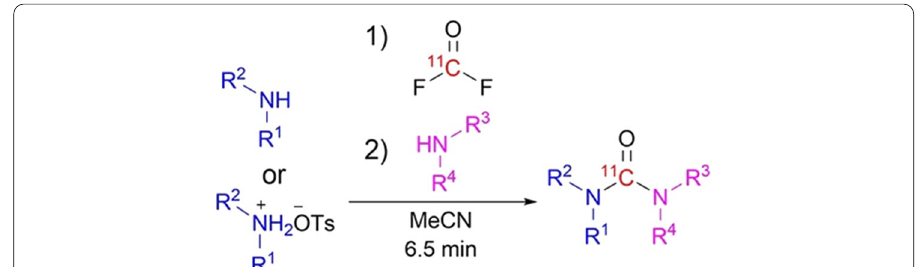
Fig. 4 The rapid and high‑yield syntheses of unsymmetrical acyclic [ 11 C]ureas under mild conditions (room temperature and within 7 min) using no‑carrier‑added [ 11 C]carbonyl difluoride with aliphatic and aryl amines are described. This new methodology is compatible with a range of functional groups and with both aliphatic amines and